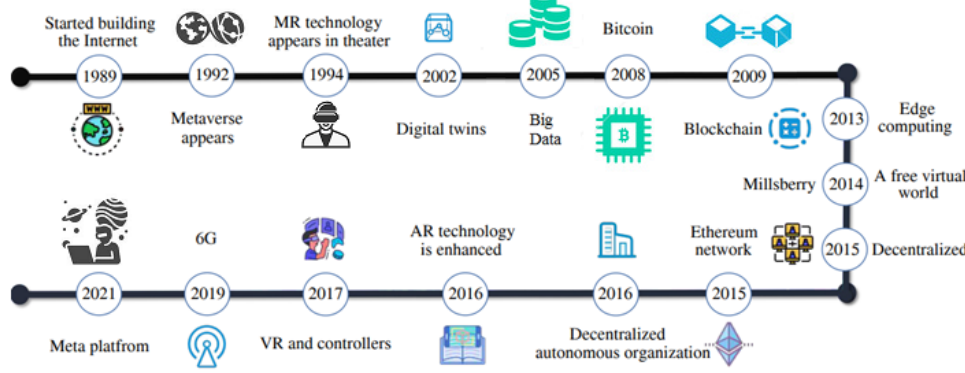
Figure 11. A chronicle of the Metaverse and its related techniques, modified based on [178].